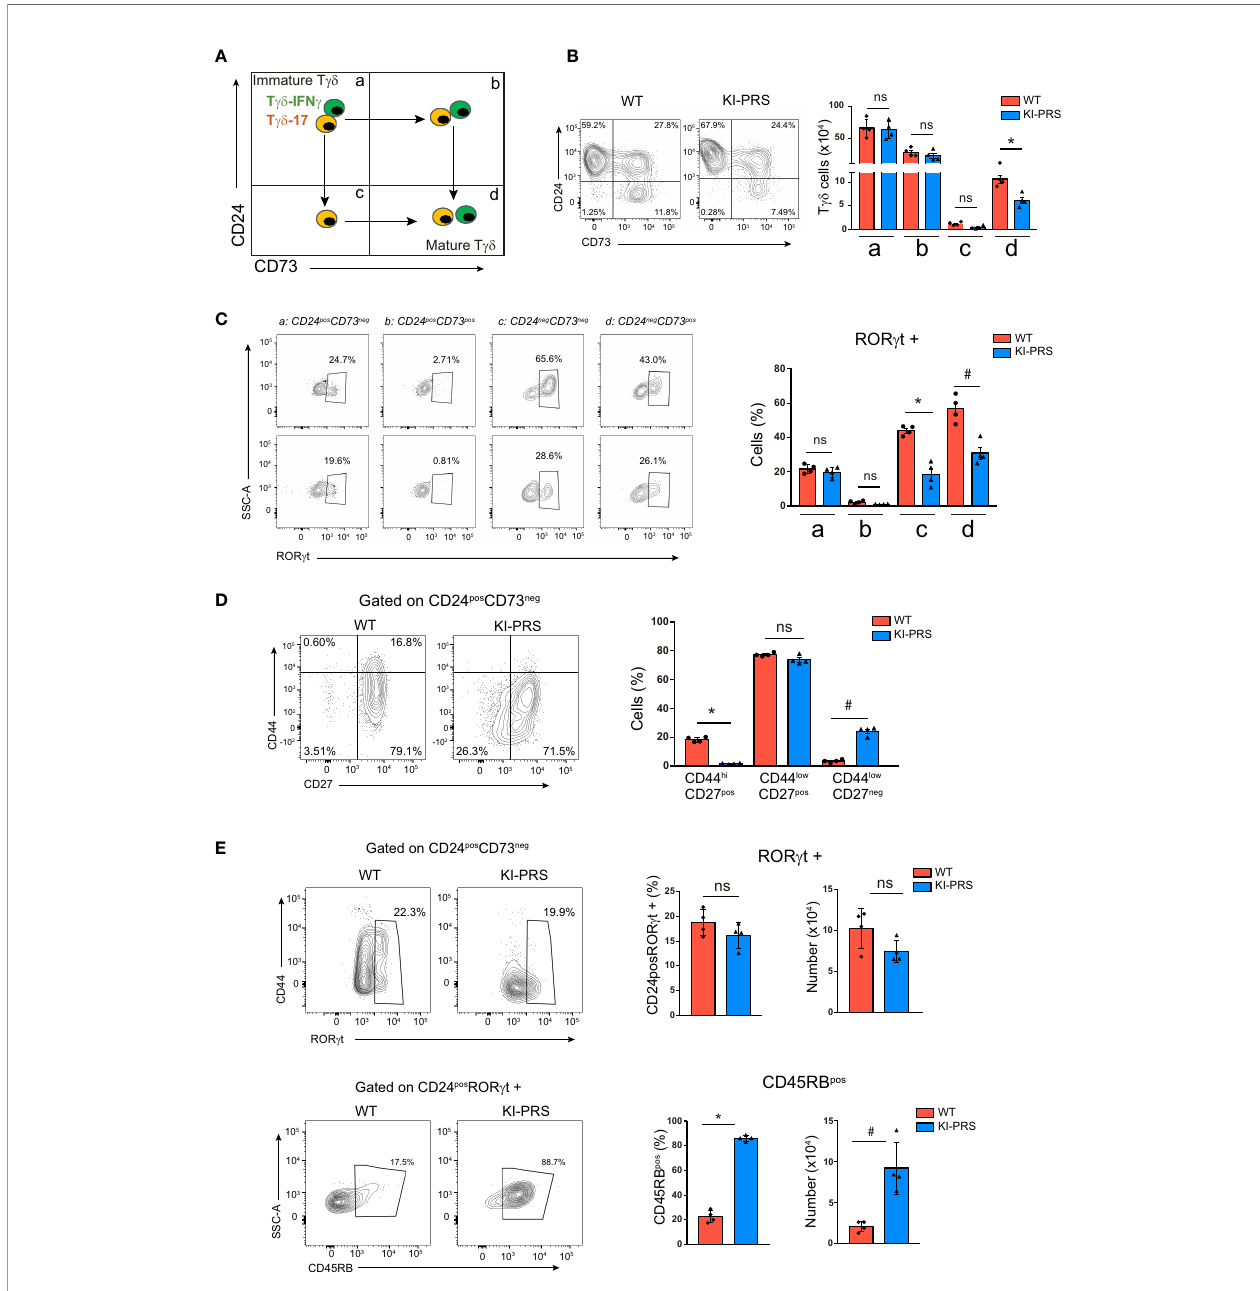
FIGURE 2 | Impairment in T gd 17 commitment in KI-PRS mice occurs in immature CD24 pos CD73 neg progenitors. Thymuses from 8-week old KI-PRS and wild-type (WT) littermates were harvested and processed for fl ow cytometry analysis of T gd cell subsets. (A) Schematic representation of the developmental stages of T gd progenitors based on CD24 and CD73 expression. (B) Representative dot plots show CD24 against CD73 expression among T gd thymocytes (gated as CD3 pos TCR gd pos ). Graph represents the absolute cell number in the quadrant regions shown in 2a (*p-value= 0.0286). (C) representative dot plots show ROR g t expression in the different stages of maturation. Graph represents the frequency of ROR g t cells in quadrant a,b,c,d (*p-value= 0.0286, # p-value= 0.0286) (D) Representative dot plots show CD44 and CD27 expression among immature T gd progenitors (gated as CD3 pos TCR gd pos CD24 pos CD73 neg ). Graph represents the frequency of cells in the indicated gates (*p-value= 0.0286, # p-value= 0.0286). (E) Top, representative dot plots show CD44 against ROR g t expression among immature T gd progenitors (gated as CD3 pos TCR gd pos CD24 pos CD73 neg ). Graphs represent the frequency and absolute cell number of ROR g t-expressing cells among immature T gd progenitors. Bottom, representative dot plots show CD45RB expression among ROR g t-expressing immature progenitors (gated as CD3 pos TCR gd pos CD24 pos CD73 neg ROR g t pos ). Graphs represent the frequency and absolute cell number of CD45RB-expressing cells among ROR g t-expressing immature progenitors (*p-value= 0.0286, # p-value= 0.0286). All graphs represent mean ± sd of n=4 mice of each genotype. Statistical analysis was performed using Mann-Whitney t-test. ns, non signi fi cant. Data are representative of 2 independent